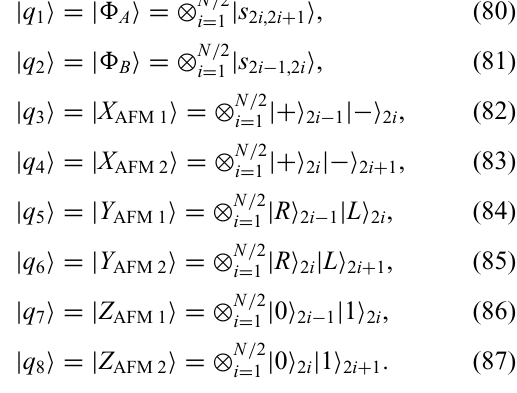
(cid:17) FIG. 4. (a) Distance d between the exact ˆ H n Hamiltonian power and the approximated Hamiltonian power ˆ H n ((cid:3) ) given in Eq. (4) without the Richardson extrapolation τ ST ( r ) ( r = 0) as a function of n for different values of (cid:3) τ . (b) Same as (a) but as a function of (cid:3) 2 τ for different values of the power n . (c) Same as (a) but with the first-order Richardson extrapolation ( r = 1) given in Eq. (14). (d) Same as (c) but as a function of (cid:3) 4 τ for different values of the power n . The inset in (d) shows the ˆ H enlarged plot for (cid:3) τ J (cid:3) 0.04. The Hamiltonian is for the spin- 1/2 Heisenberg model on an N = 24 qubit ring given in Eq. (65). ˆ The lowest-order symmetric Suzuki-Trotter decomposition S 2 is used. The error bar indicates the standard error of the mean. The solid lines are a guide for the eye. Note that each panel employs a different scale in the y